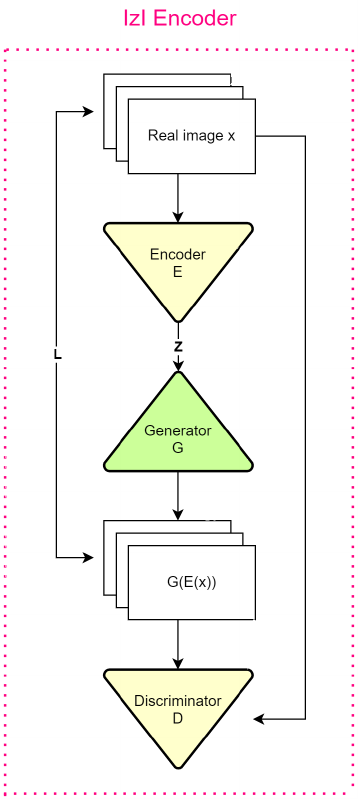
Figure 6. izi f Encoder